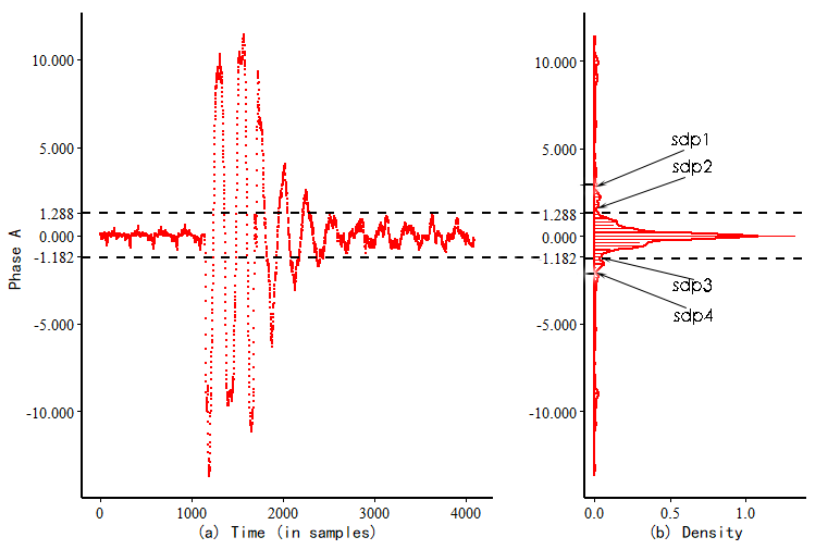
Figure 5. Projection fast segmentation algorithm of A-phase voltage sag data (id 01), where ( a ) is the filter sequence of the A-phase (id 01) and ( b ) is the corresponding kernel density